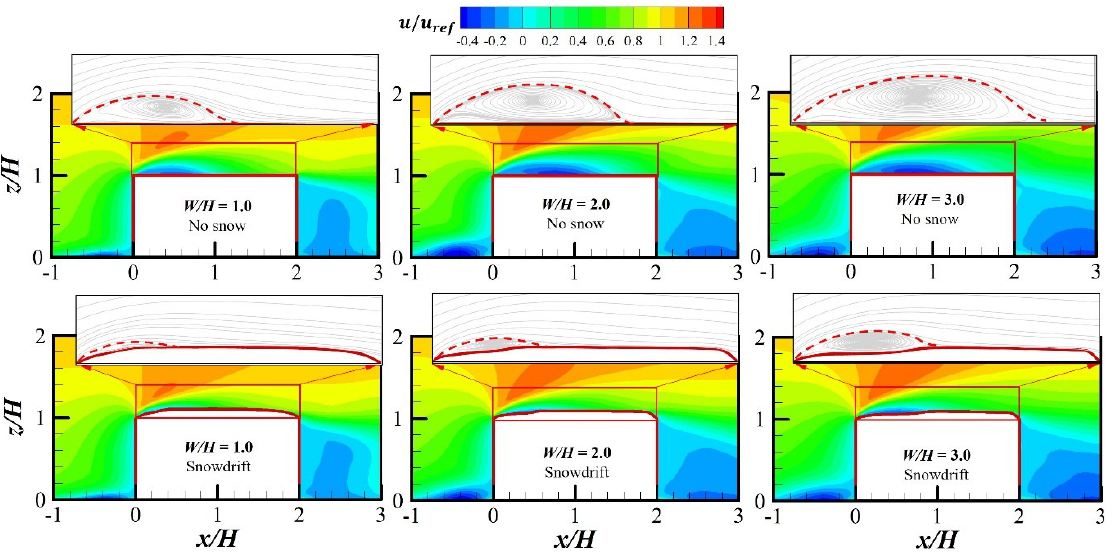
Figure 9. Contours of 𝑢̅/𝑢 𝑟𝑒𝑓 and streamlines at xoz planer.